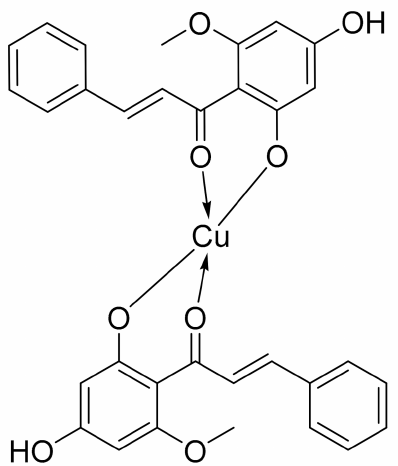
Figure 1. Structure of Cu (II)–cardamonin complex ( 19 )